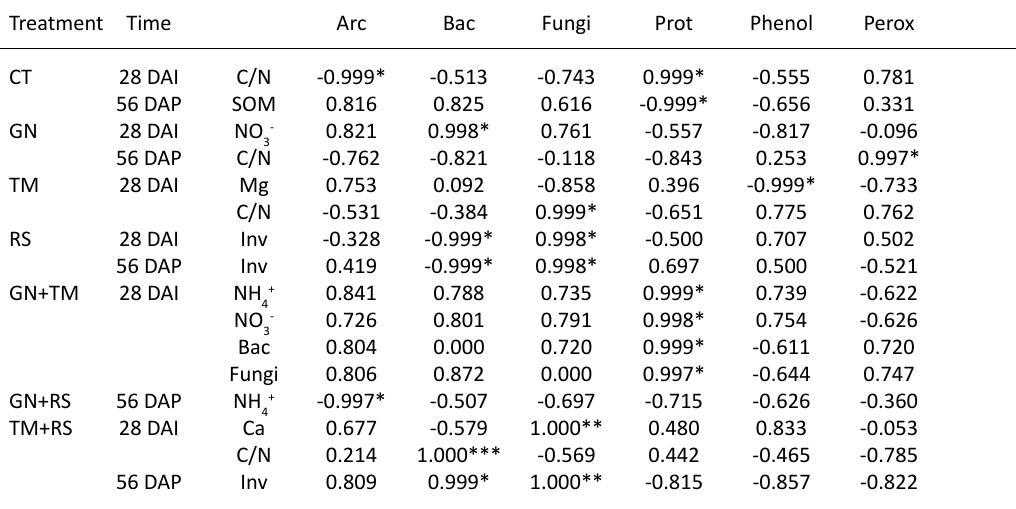
Table 5. Pearson's correlation coefficients (r) between biological properties and soil chemical properties for each treatment evaluated at initial stage of the experiment, 28 days after incorporation (DAI) and 56 days after planting (DAP) Treatment Time